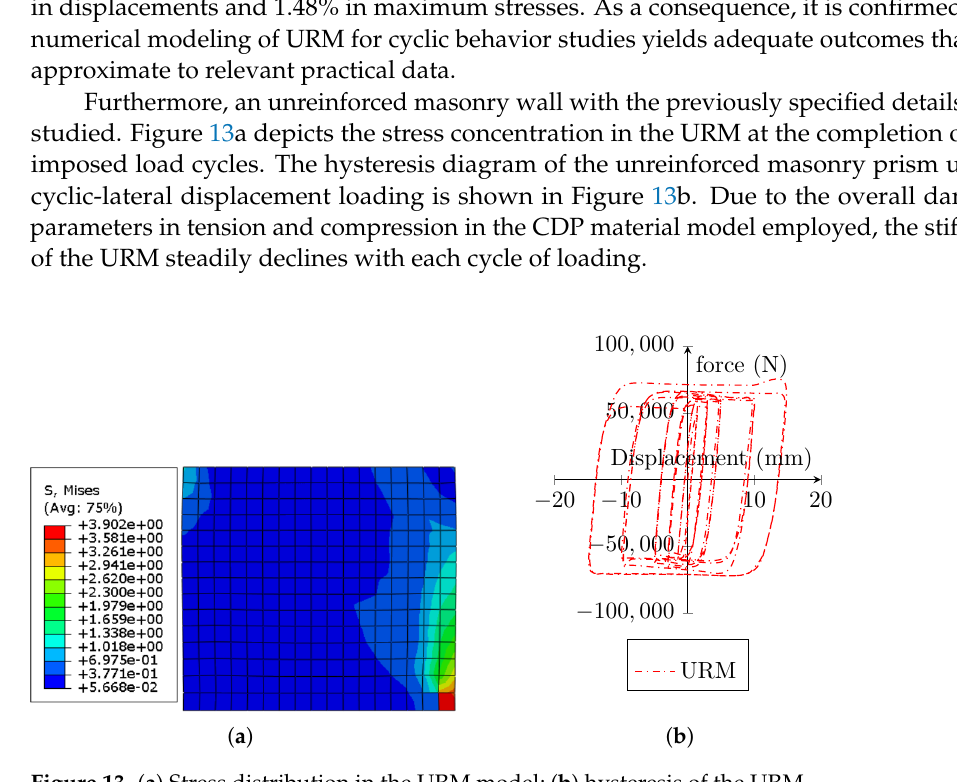
Figure 13. ( a ) Stress distribution in the URM model; ( b ) hysteresis of the